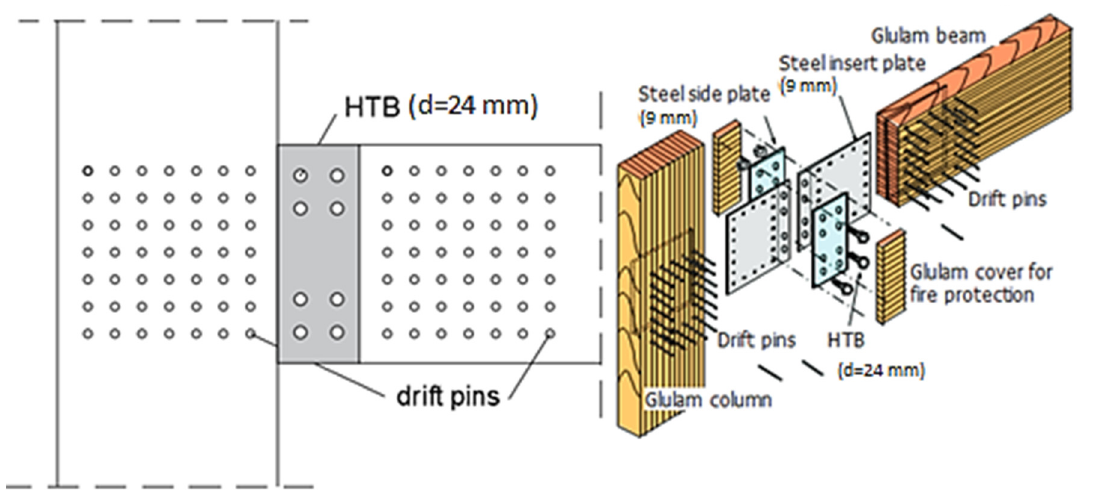
Figure 5. Bolted slotted-in steel plate connection applied in frame tested by [20]. Based on this research, it is possible to conclude that the application of nailed steel side-plate or bolted slotted-in steel plate connections without any type of reinforcement did not ensure a ductile behavior. When subjected to monotonic and cyclic loads, these